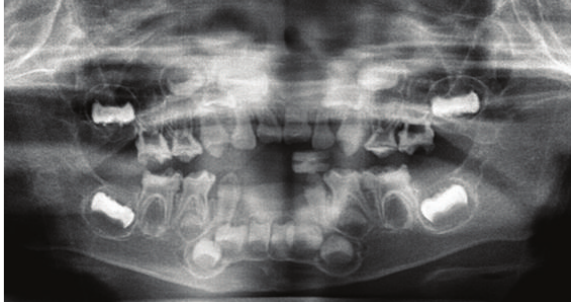
Figure 2: Panoramic radiographic appearance at age of 3 years and 2